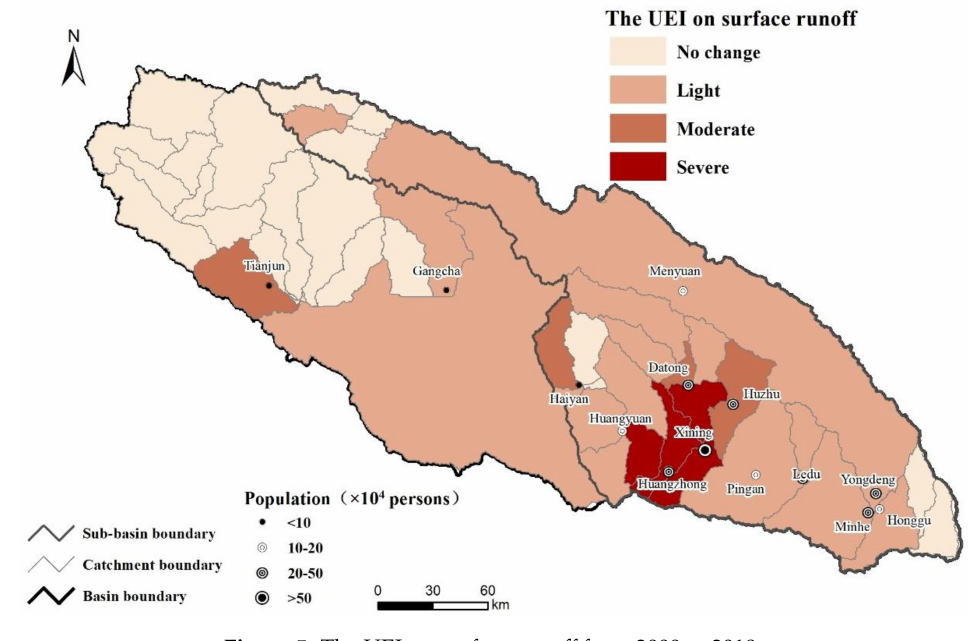
Figure 5. The UEI on surface runo ff from 2000 to 2018. Table 5. The UEI on surface runo ff from 2000 to 2018.